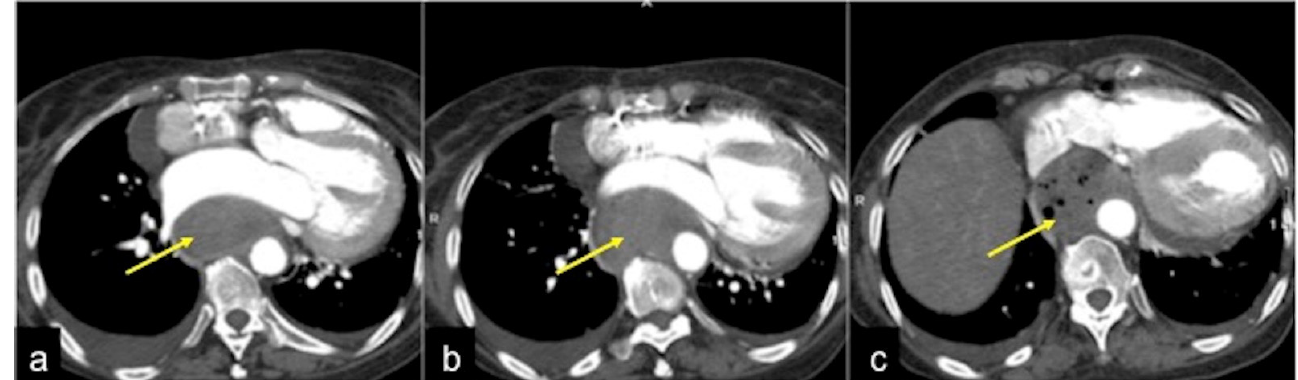
evaluation reveals signs of active bleeding ( c ).